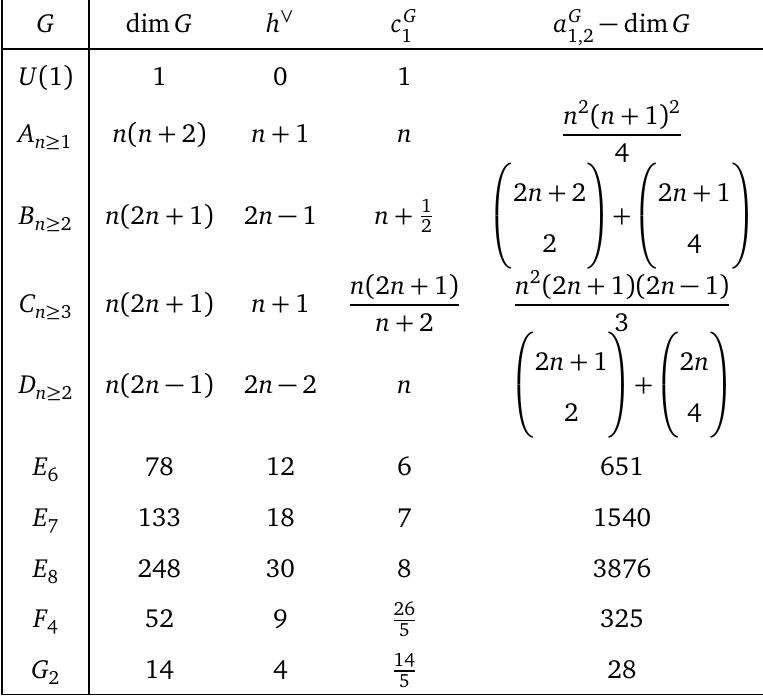
Table 2: Data for U ( 1 ) and compact simple Lie groups, including the dimension, the dual coxeter number h ∨ , as well as the central charge and q 2 coefficient of the level-1 affine current algebra. G dim G h ∨ c G